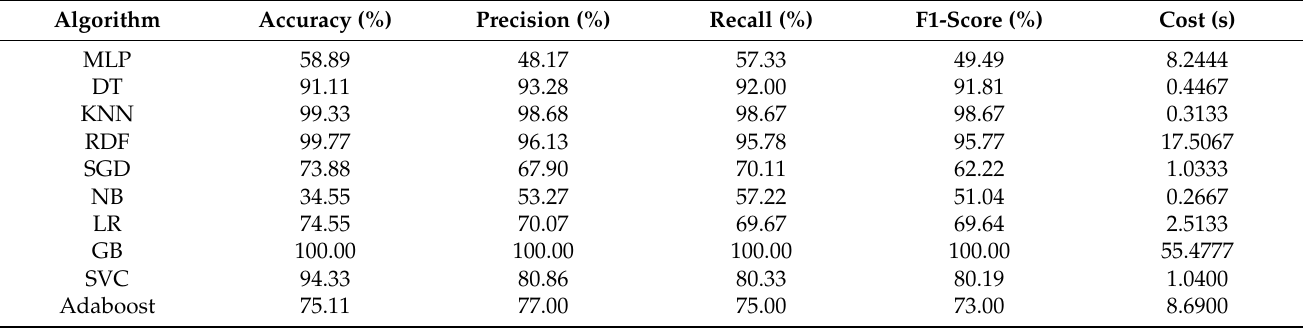
Table 5. Global performance comparison of ML models using all feature sets.